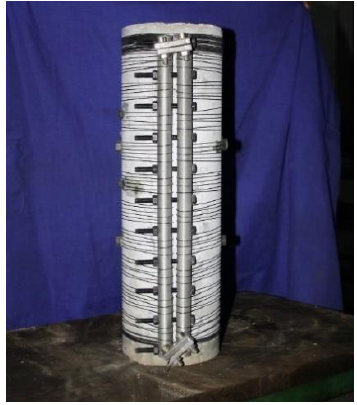
Figure 3. A SMA reinforced concrete cylinder with a wire tensioning and anchoring device.